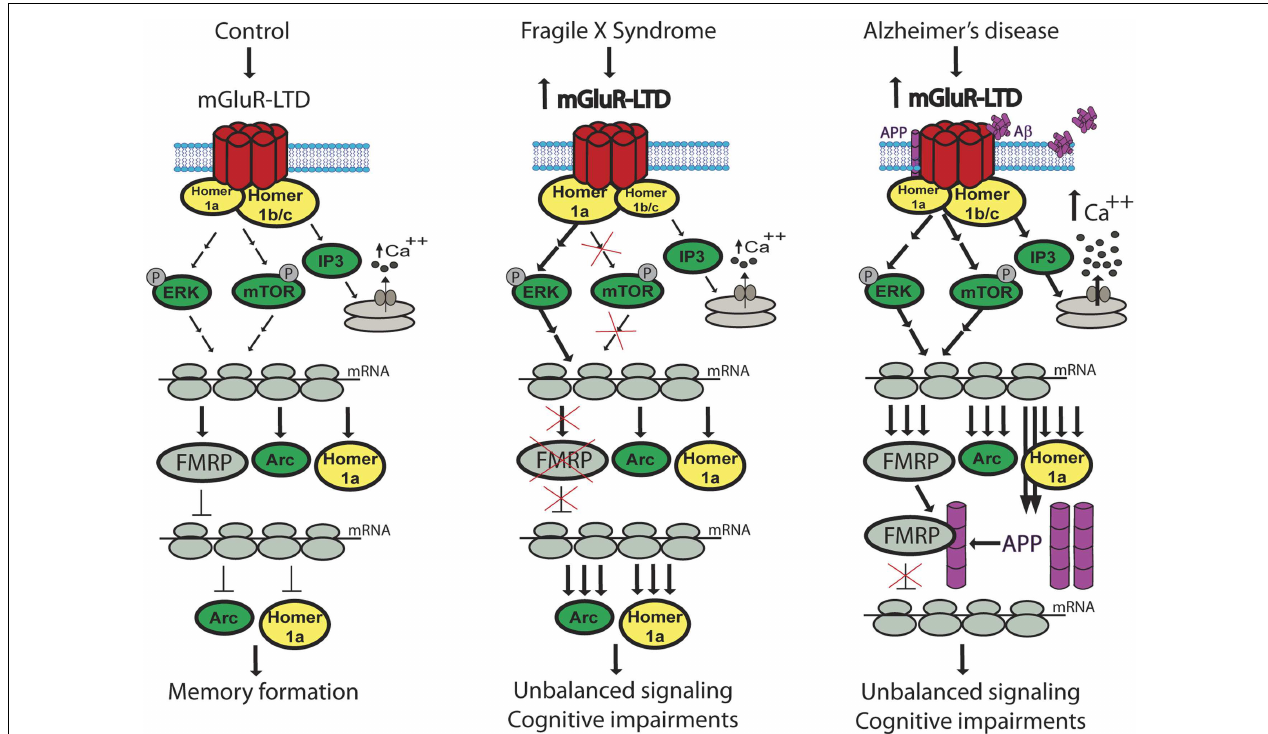
protein synthesis related to the mTOR pathway is lost. Moreover, mGluR5 is associated more with Homer 1a stimulating agonist-independent signaling pathways.Without FMRP to decrease the protein translation, LTD-related proteins are overexpressed and memory is impaired. Excessive mGluR-LTD has also been reported in Alzheimer’s disease. A β oligomers clusters mGluRs on the plasma membrane promoting Ca 2 + signaling and release from intracellular stores. Stimulation of group 1 mGluR also increases APP translation. FMRP can bind to APP possibly altering the protein synthesis negative control and creating memory